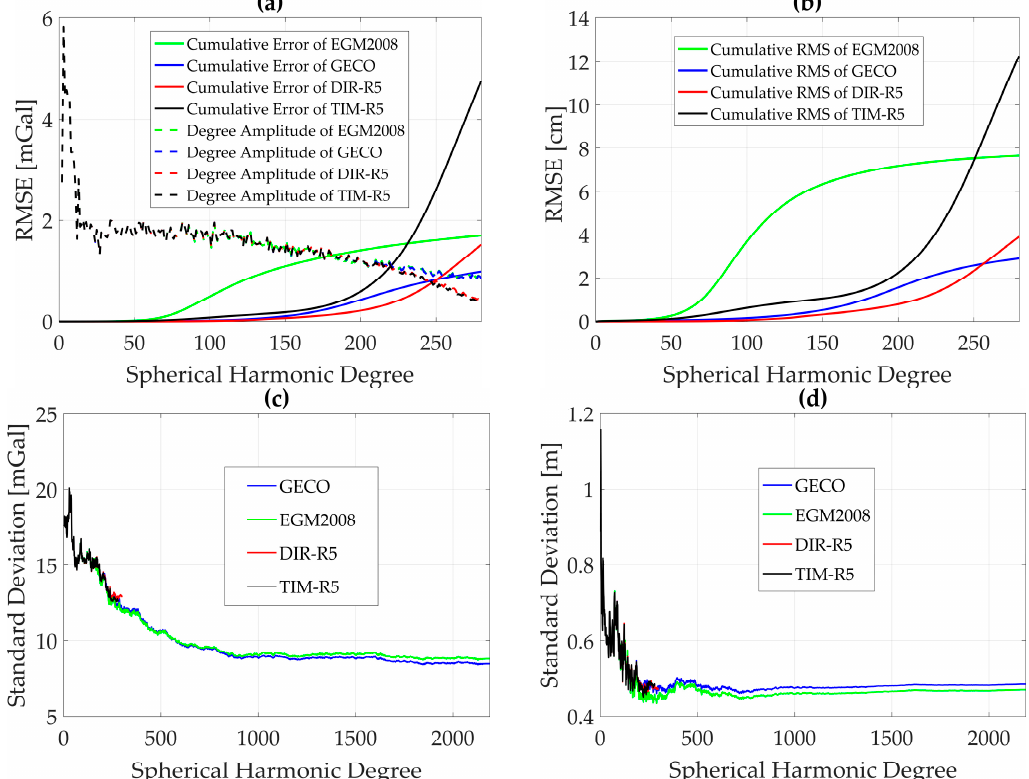
Figure 2. GGM inter-comparison and comparison with terrestrial data. The dashed lines in panels ( a ) and ( b ) are the cumulative RMSEs, while the solid lines represent the degree amplitudes. ( a ) Inter-comparison of GGMs based on gravity anomaly; ( b ) Inter-comparison of GGMs based on geoid heights; ( c ) Comparison of terrestrial gravity anomaly and gravity anomalies computed from GGM; ( d ) Comparison of GPS/trigonometric heights with GGM geoid undulations.